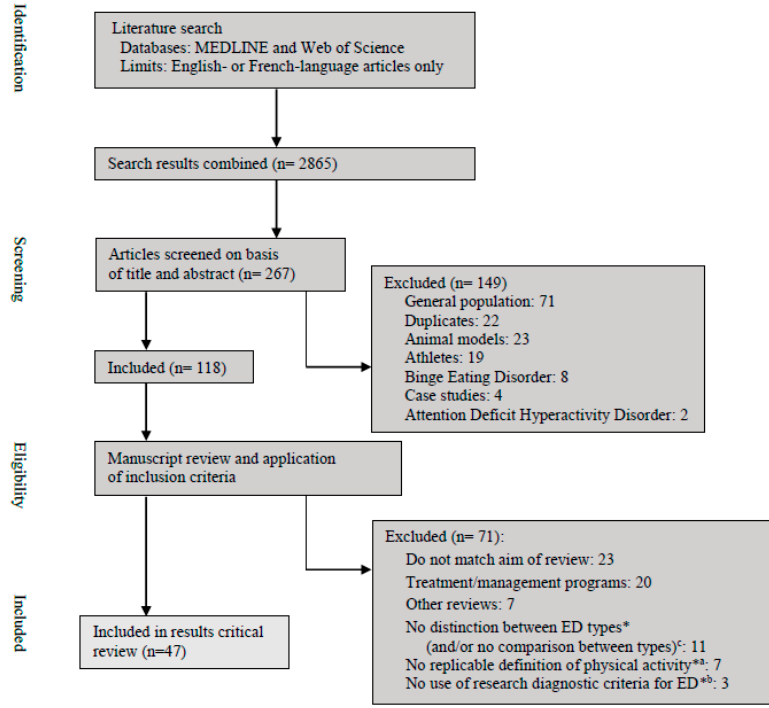
Figure 1. Flow diagram of the study selection. * Studies excluded for one or more reasons. a Blumenthal et al. (1984) [19]; Crisp et al. (1980) [20]; Davis et al. (1994) [21]; Frey et al. (2000) [22]; Kron